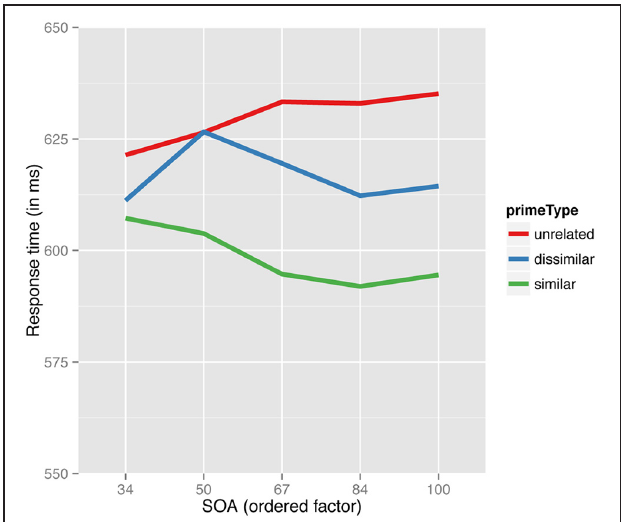
FIGURE 4 | Tensor product smooths for the non-linear interaction of the principal component for form-related neighboring words (PC1) and frequency of occurrence (PC2). Green indicates shorter response latencies, and yellow-to-brown indicates longer response latencies at a range of SOAs ranging from 34 to 100